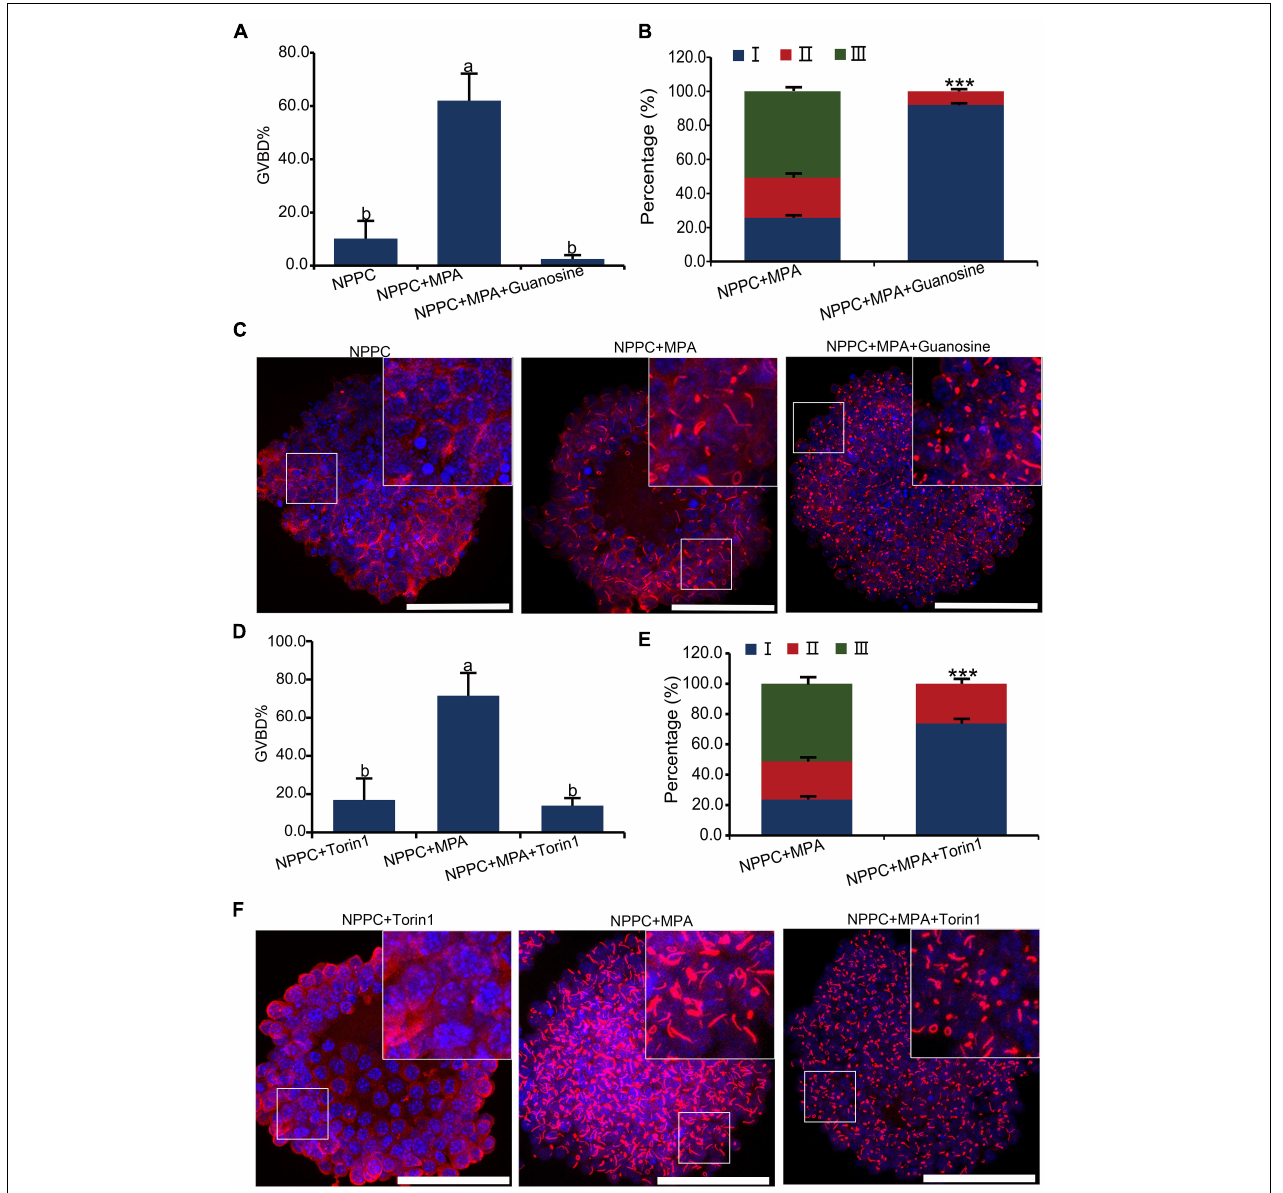
FIGURE 6 | Effects of guanosine supplementation and MTOR inhibition on MPA-induced reversal of oocyte meiotic arrest and aggregation of IMPDH2 into cytoophidia in cumulus cells. (A–C) Treating COCs with 200 nM- guanosine inhibits MPA-induced oocyte GVBD (A) and formation of IMPDH2 cyoophidia in cumulus cells (B,C) . (D–F) Treating COCs with MTOR inhibitor Torin1 (1 µ M) inhibits MPA-induced oocyte GVBD (D) and formation of IMPDH2 cyoophidia in cumulus cells (E,F) . Scale bars: 50 µ m. Bars without letters in common are considered significantly different ( P < 0.05). *** P <